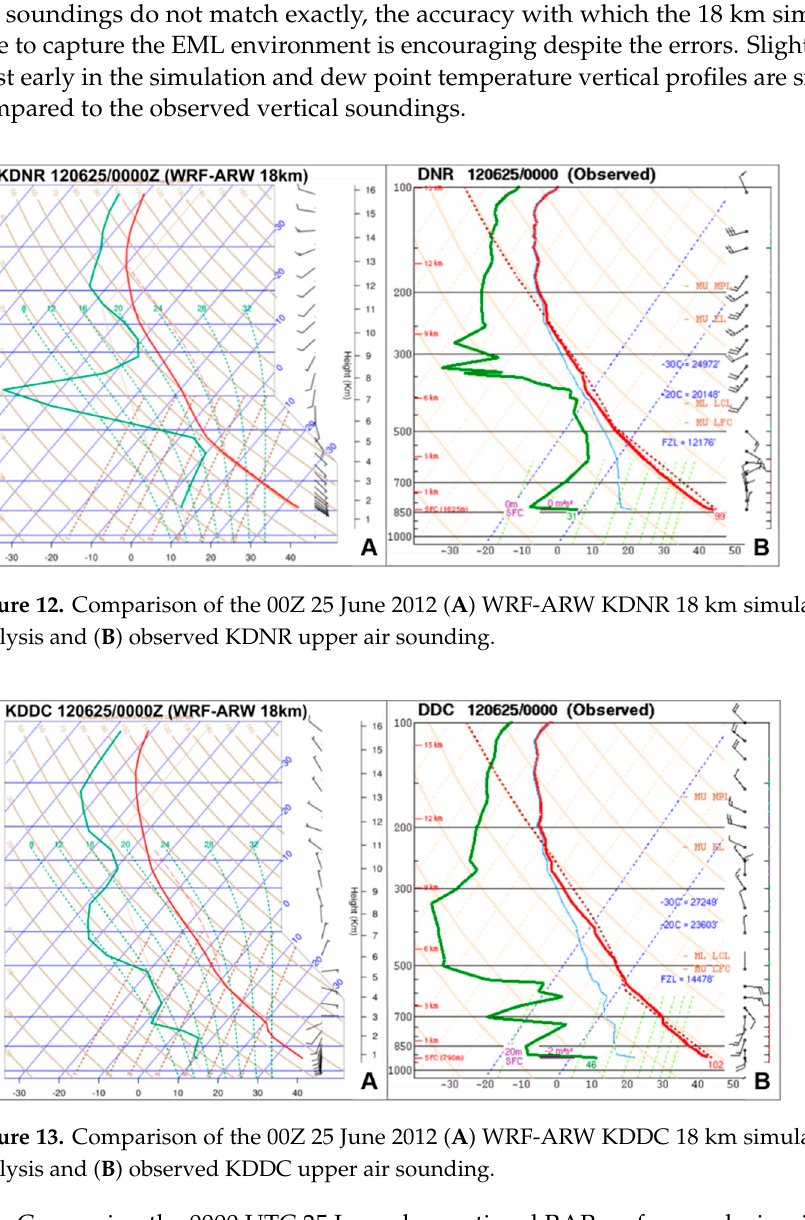
Figure 11. Comparison of 18Z 29 June through 04Z 30 June 2012 hourly ( a ) observed composite Doppler radar reflectivity (modified by Greg Carbon [19]) and ( b ) WRF-ARW 2-km simulated max- imum reflectivity (dBz) values.